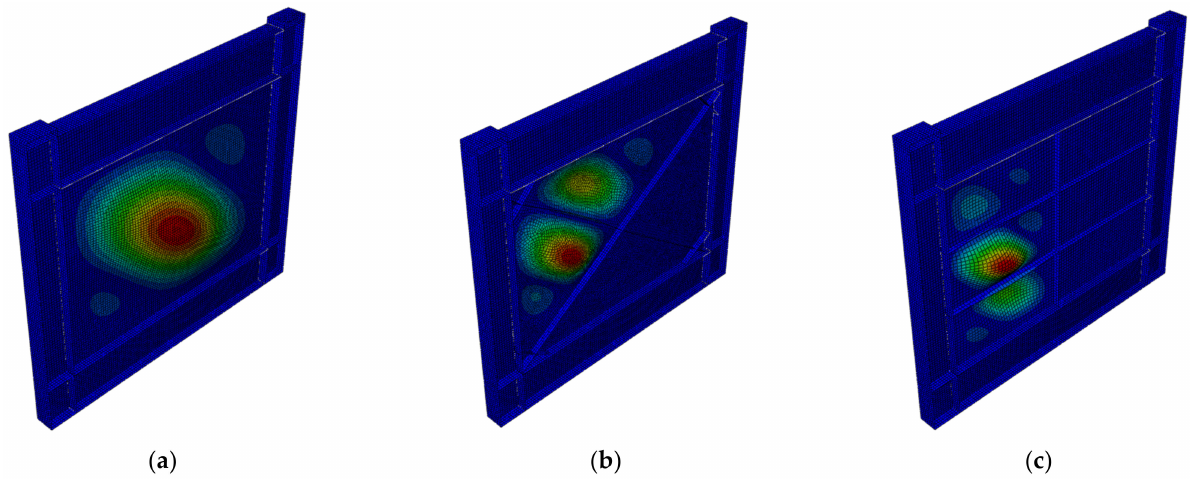
Figure 14. Buckling mode diagram of SPSW. ( a ) A075. ( b ) A075-P. ( c ) A075-HV.